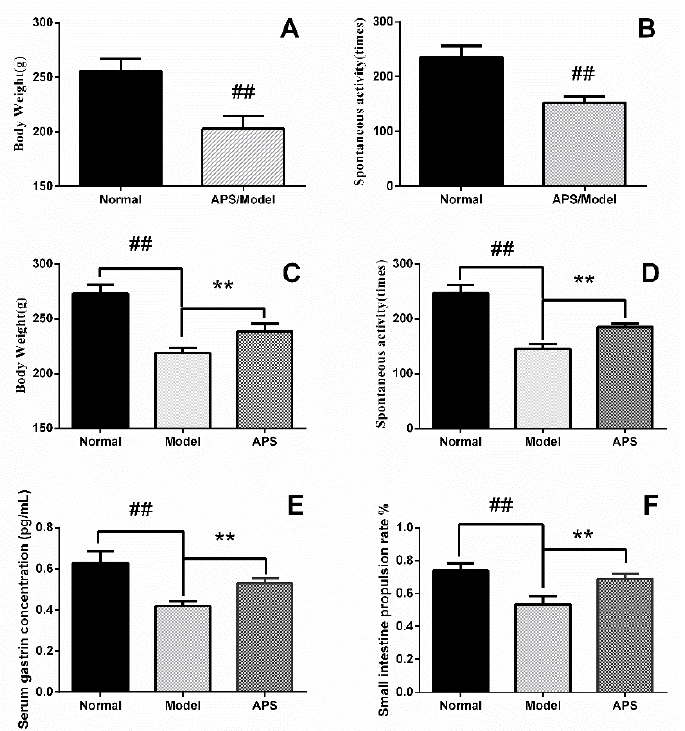
Figure 1. Body weight and spontaneous activity of the control (normal) group and the Astragalus polysaccharide (APS)/model group ( A ), ( B ). The values given are the means ± SD (n = 7 in normal group, n = 14 in APS/model group). After APS intervention, the change of body weight, spontaneous activity, gastrin concentration, and small intestine propulsive rate in the normal group, model group, and APS group are shown in ( C ), ( D ), ( E ), ( F ). The values given are the means ± SD (n = 7); ## p < 0.01 compared with the normal group, ** p < 0.01 compared with the APS group.